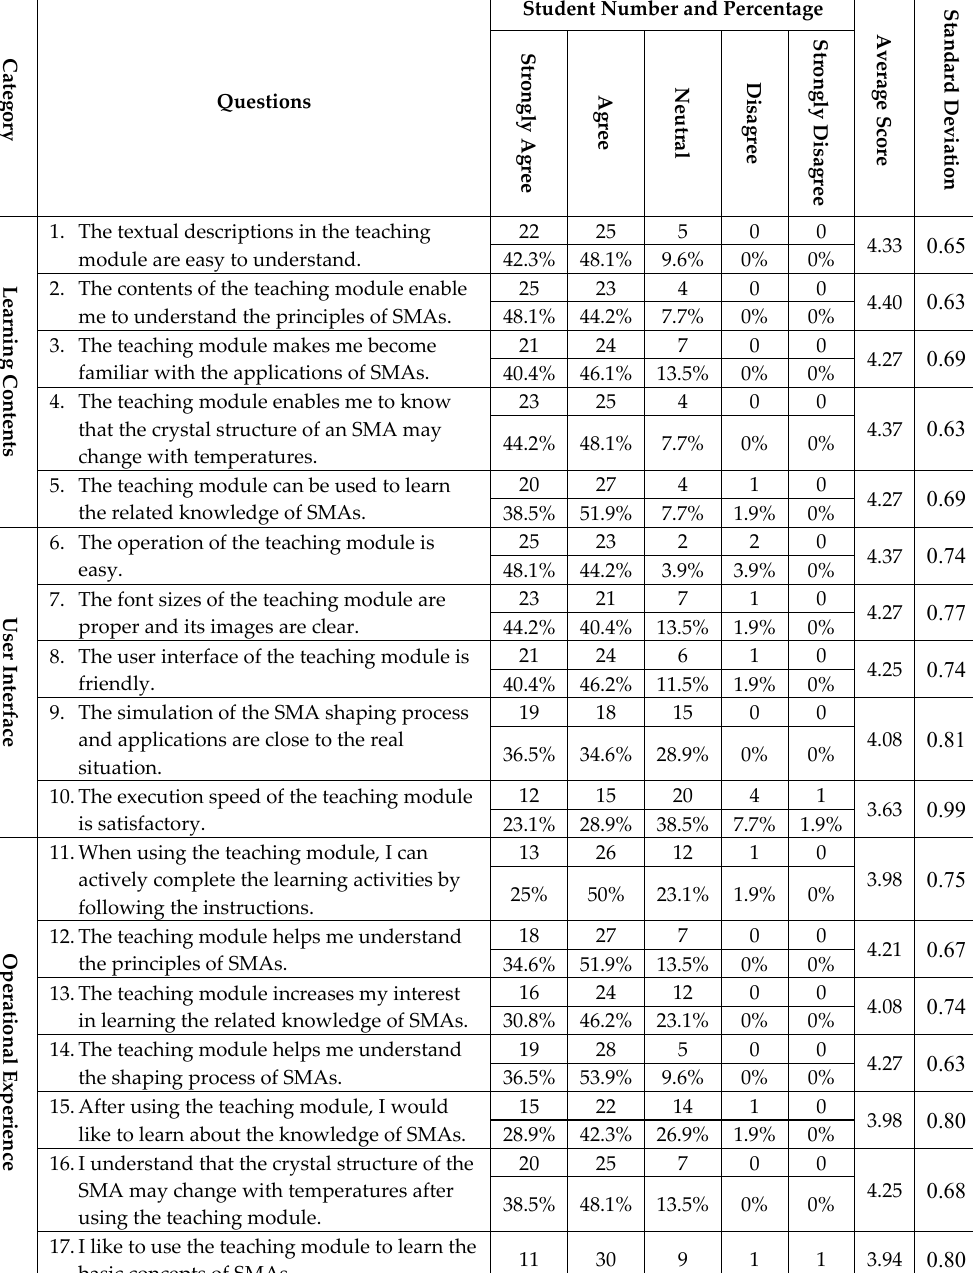
Table A1. Questionnaire Results by Students after Using the Teaching